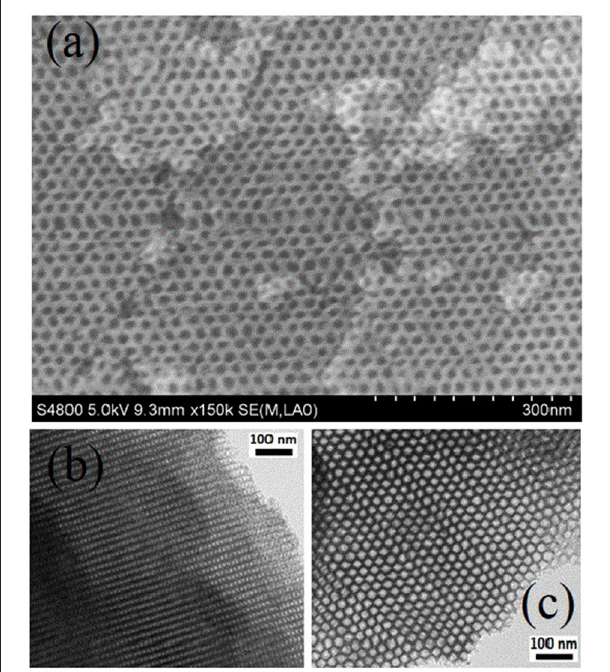
FIGURE 4 | SEM images of catalyst 3, (b,c) TEM images of catalyst 1 viewed along the (a) [100] and (b) [110]